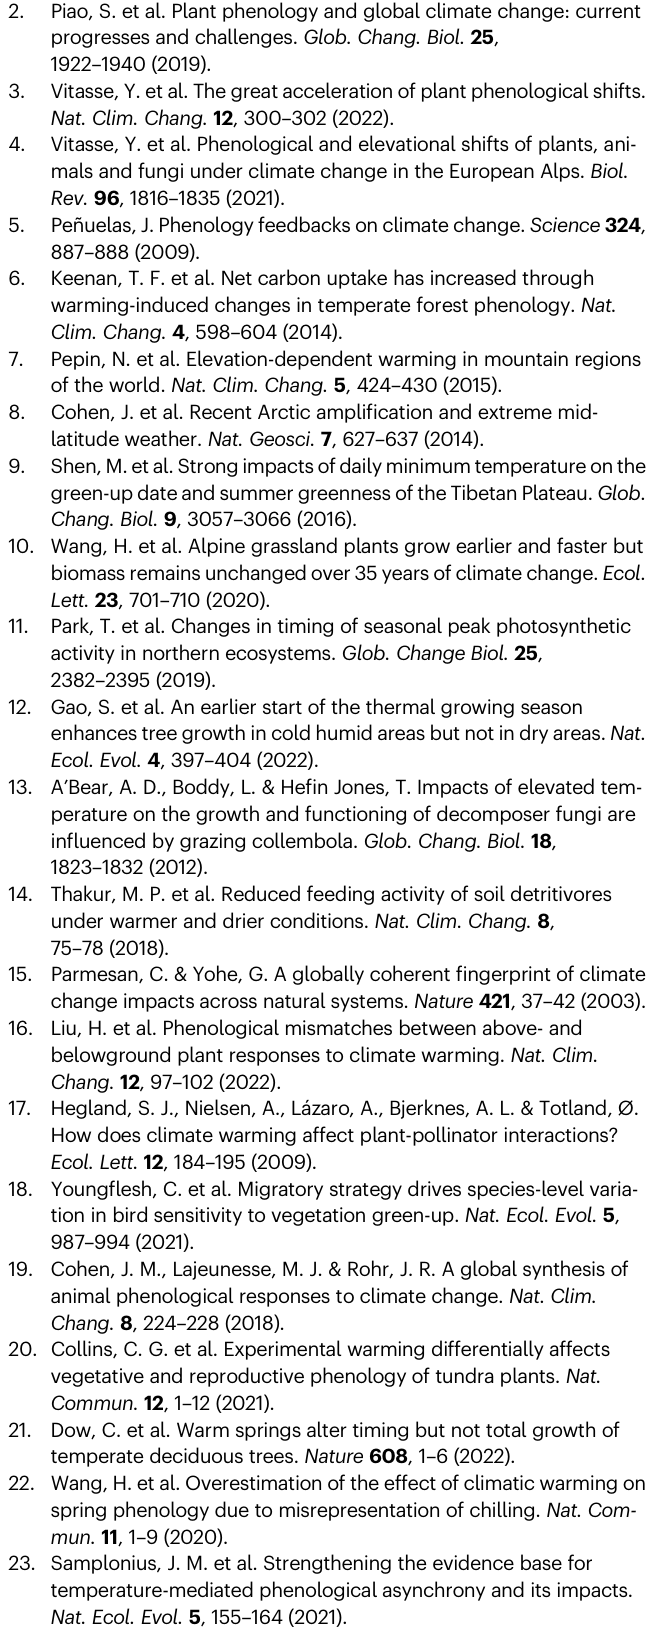
Figshare: https://doi.org/10.6084/m9. fi